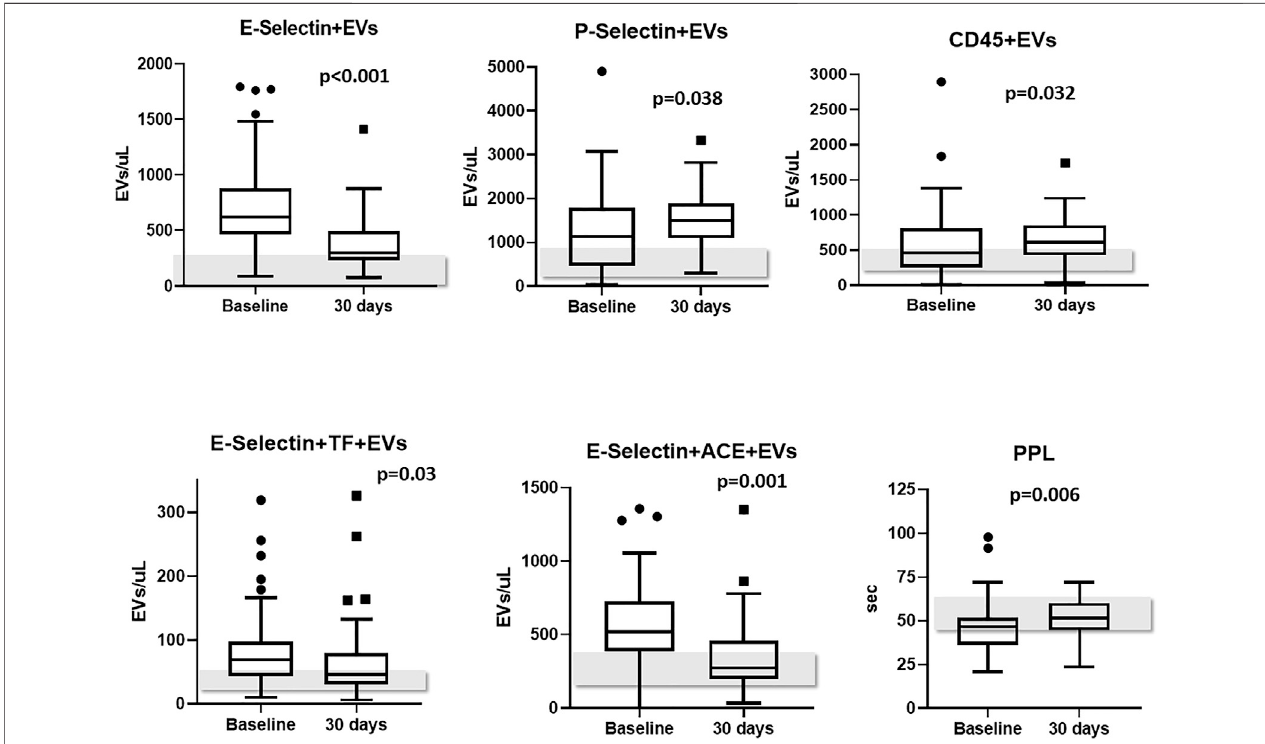
FIGURE 2 | EVs subtypes signi fi cantly changed from baseline to 30-days follow-up. Levels of EVs measured in healthy controls are reported as grey bars; Abbreviations: EVs: extracellular vesicles; ACE2: angiotensin-converting enzyme-2.